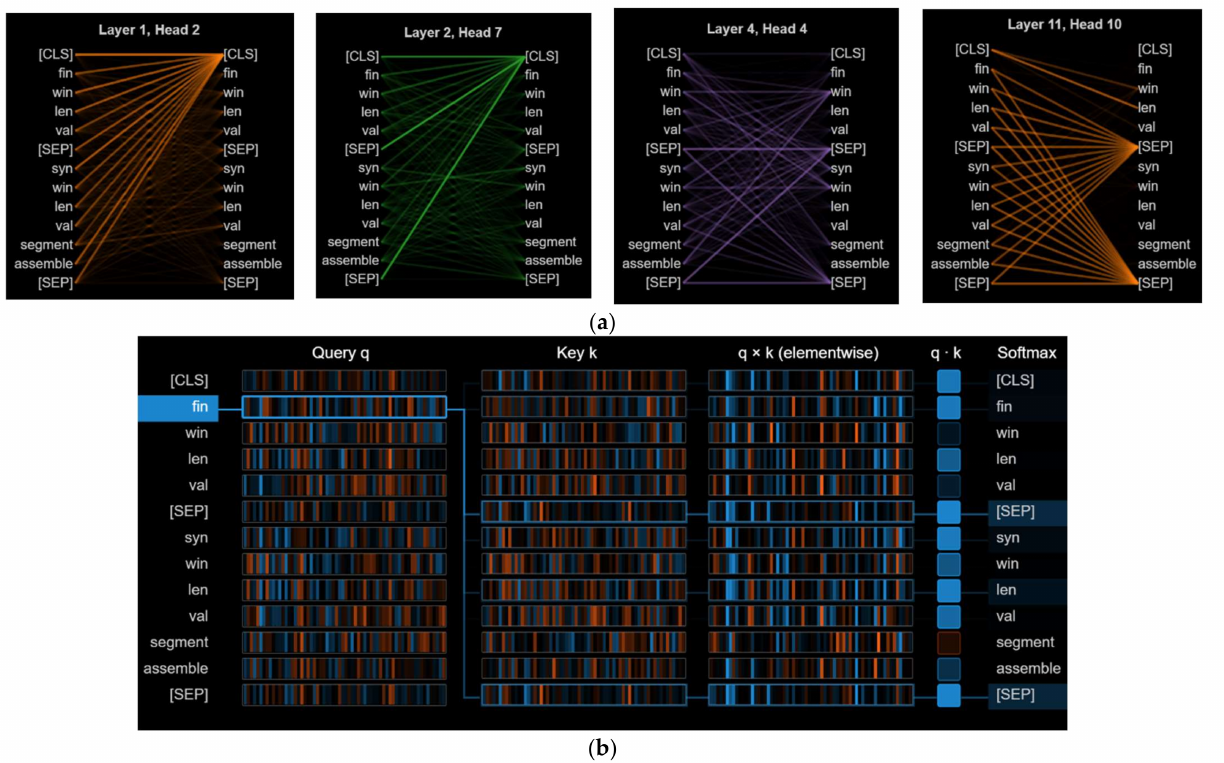
Figure 4. Visualization attention for network traffic data using the BERT pre-trained model: ( a ) head view visualization attention with different layers using Tensor2Tensor; ( b ) neuron view visualization between Query q and Key k.